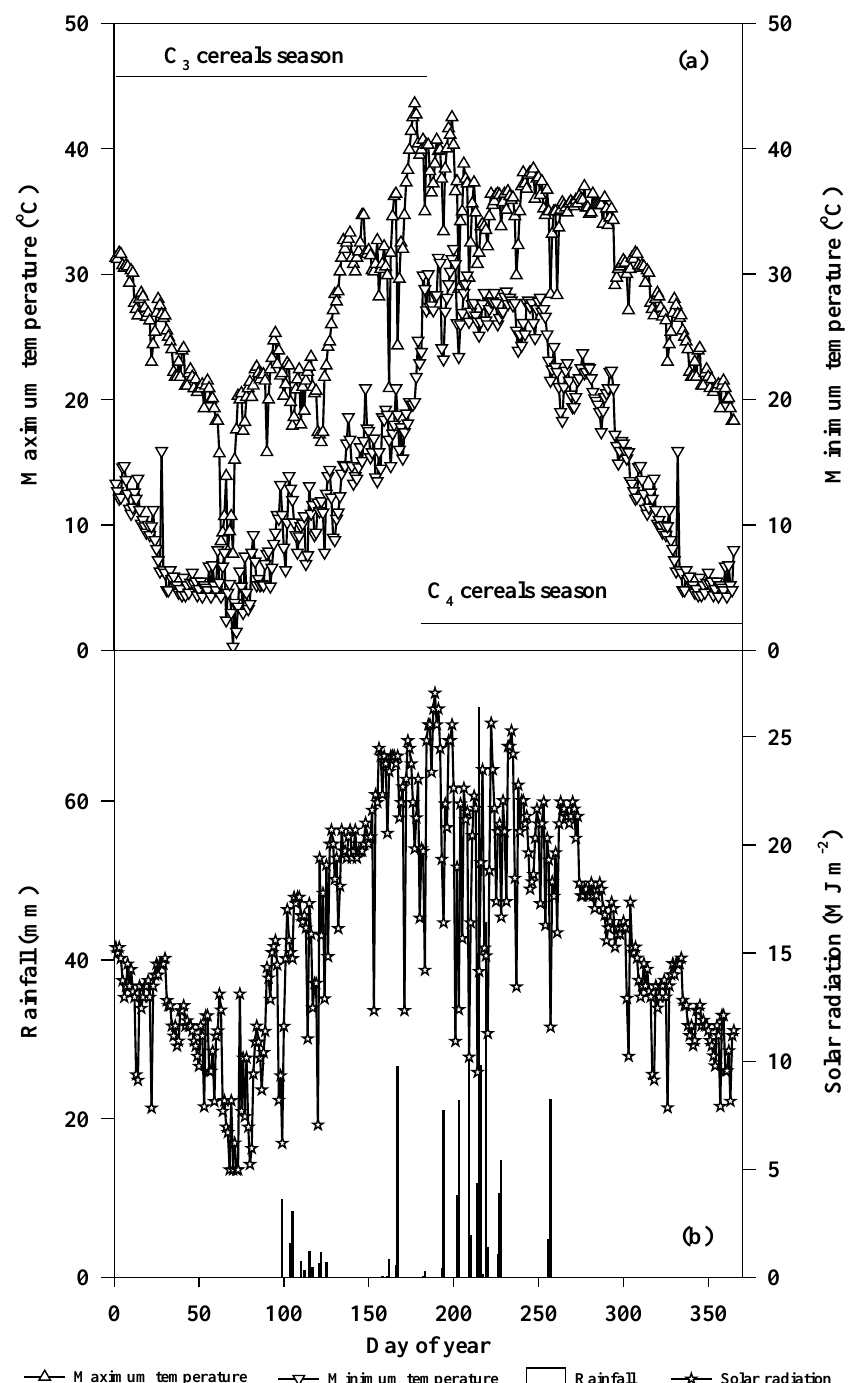
Figure 4. ( a ) Daily maximum (upward triangles) and minimum (downward triangles) temperatures, precipitation (unfilled bars), and solar radiation (unfilled stars) ( b ) during C 3 and C 4 cereal seasons (represented by lines) at Multan, Pakistan.